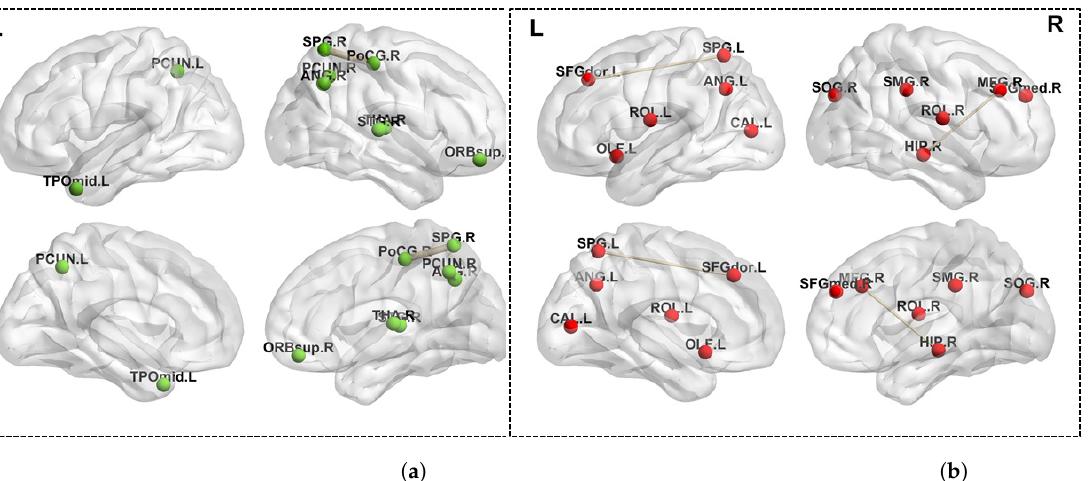
Figure 6. Brain nodes with ( a ) positive and ( b ) negative correlation with autism severity symptoms (SRS score) as listed in Table